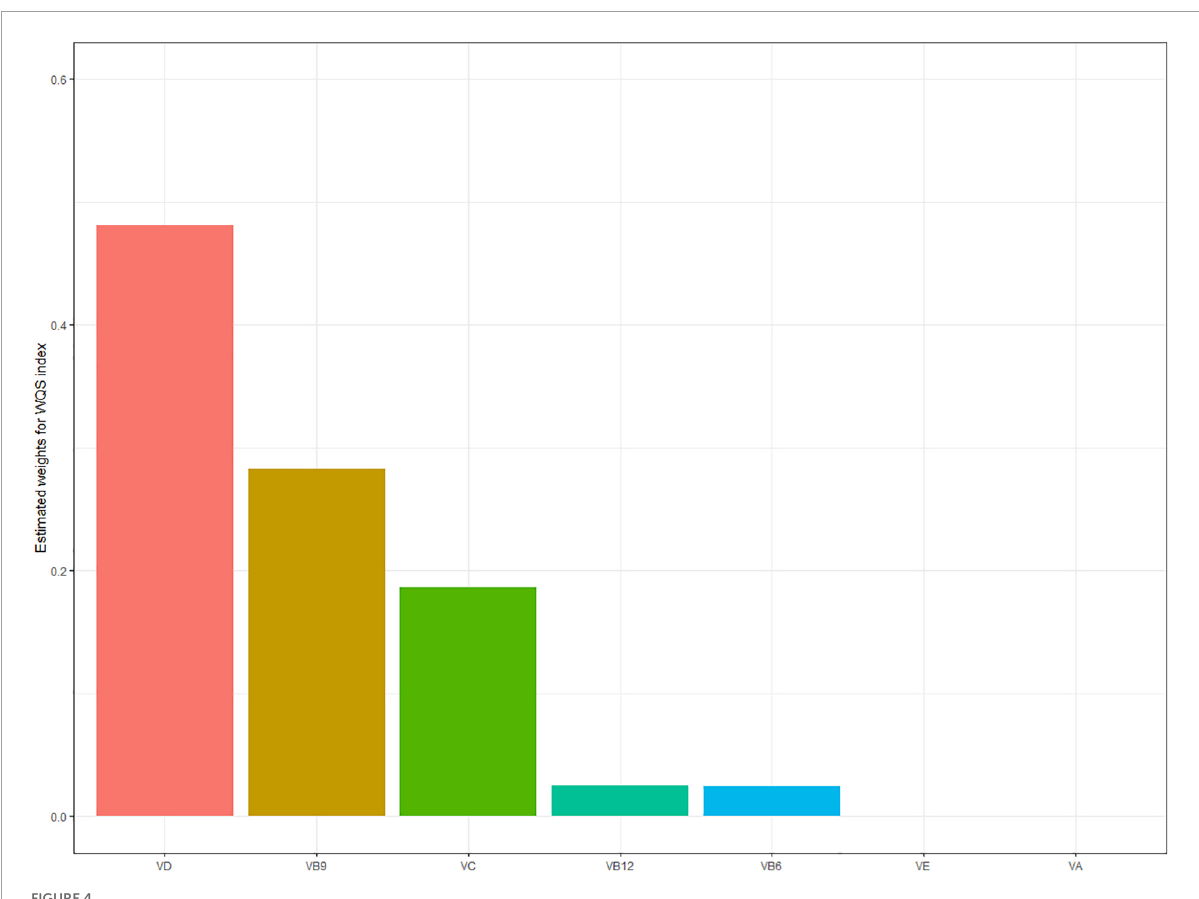
FIGURE4 Estimated weights assigned to each vitamin level with the WQS regression model in a negative direction. Model adjusted for gender, age, ethnicity, FIPR, education level, and disease history (hypertension, high cholesterol, and